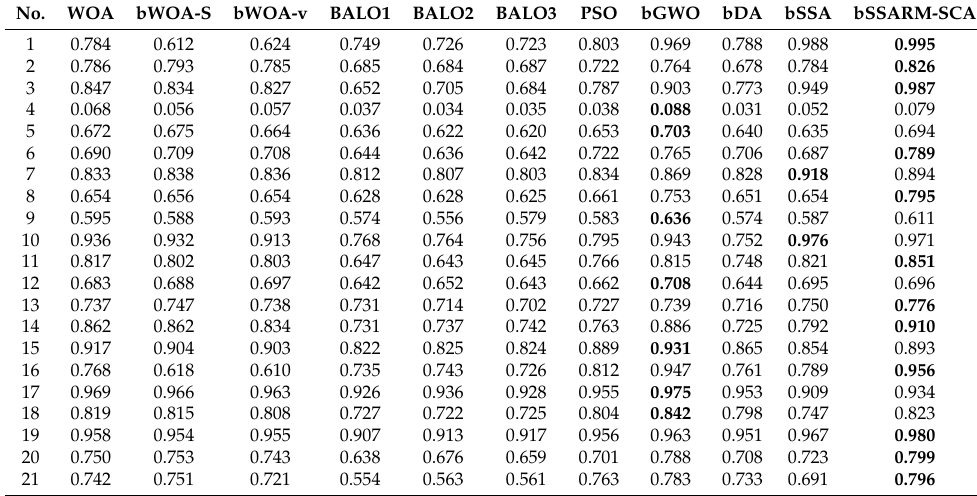
Table 15. Classification accuracy using mixed initialization for the 21 utilized